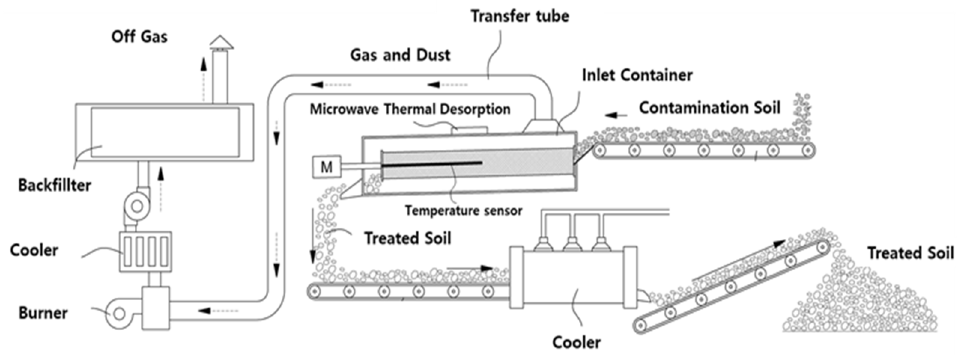
Figure 2. Process of indirect-heated microwave thermal desorption treatment.